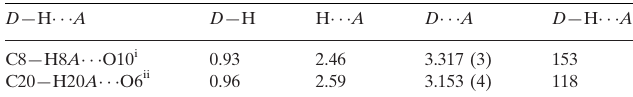
Hydrogen-bond geometry (A˚ , (cid:2) ). D —H (cid:3)(cid:3)(cid:3)